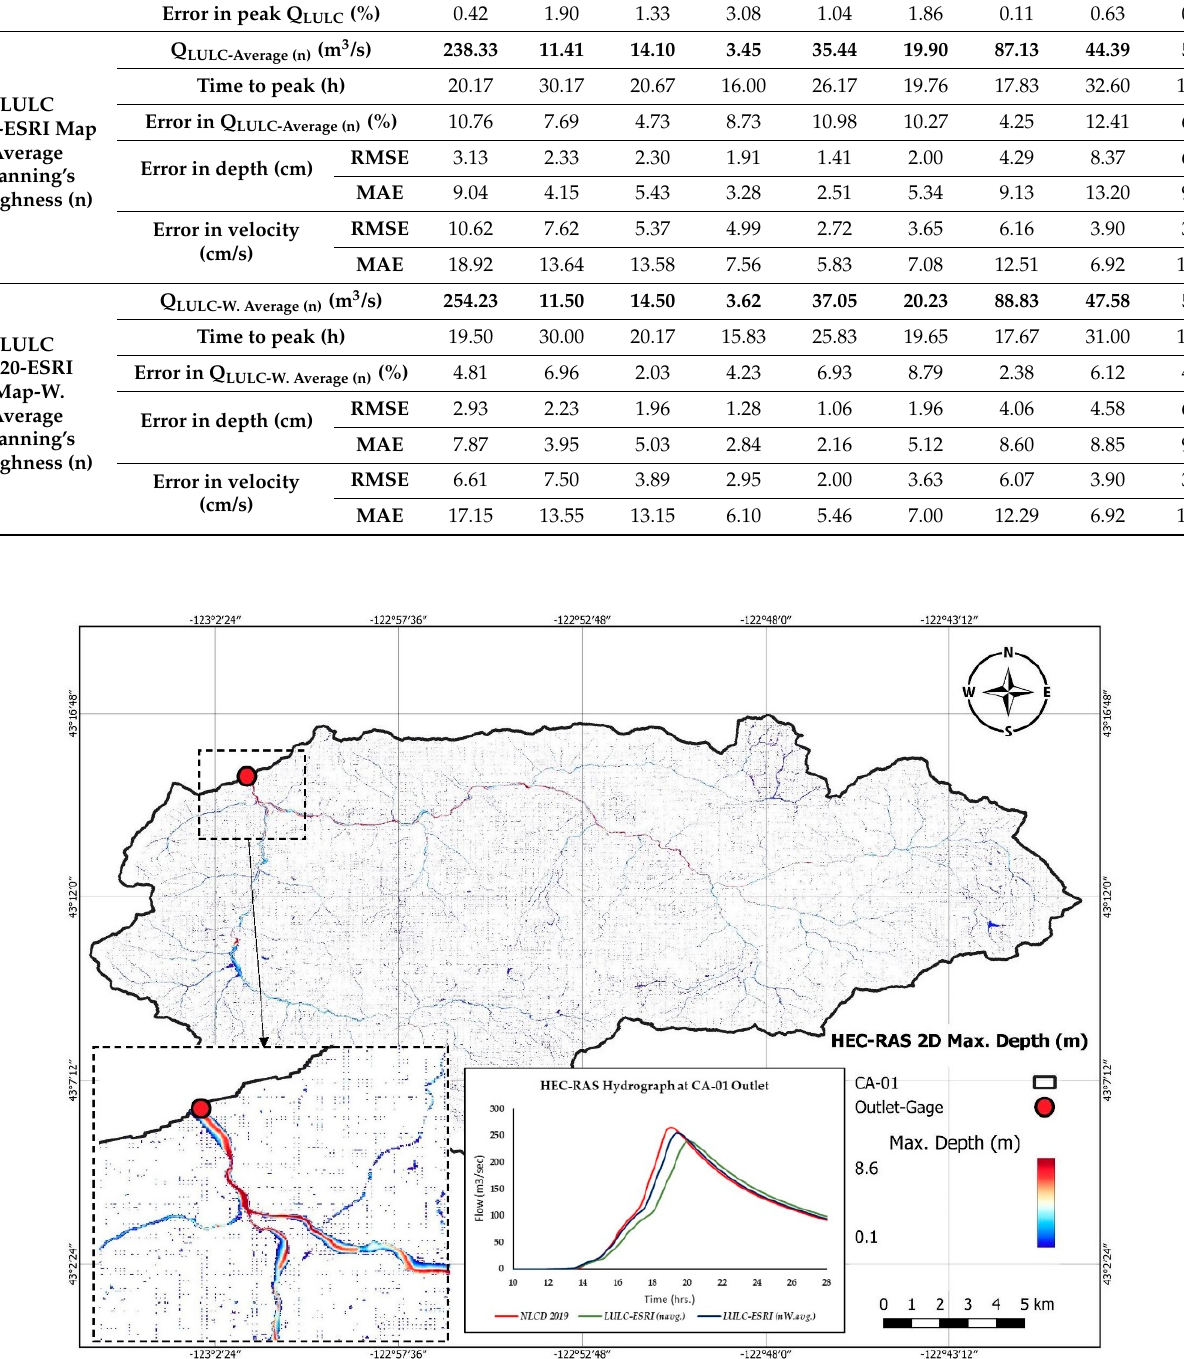
Table 8. Calibration data and analysis results for a 2- years return period.